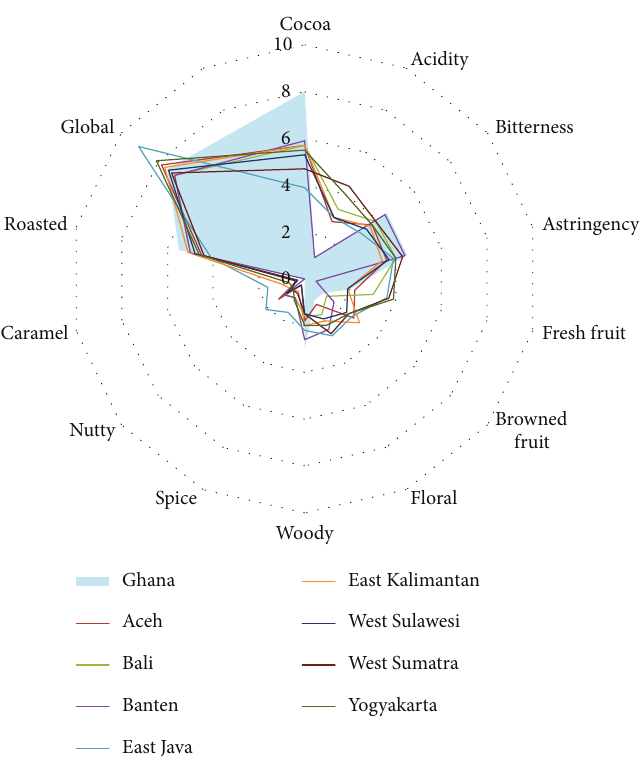
Figure 5: Sensory pro fi le of cocoa bean samples from Ghana and various regions of Indonesia. The scores indicated intensity of each sensory attributes ranging from 0 – 1 (none to trace), 2 – 3 (weak), 4 – 6 (clear), 7 – 8 (strong), and 9 – 10 (overpowering). The values were mean of seven replications.